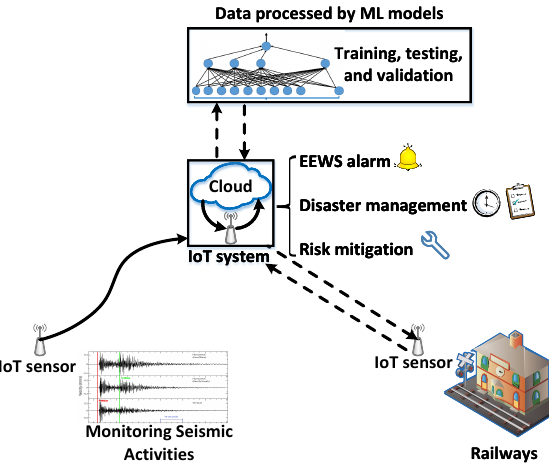
Figure 4. A sample of IoT-ML interconnection for